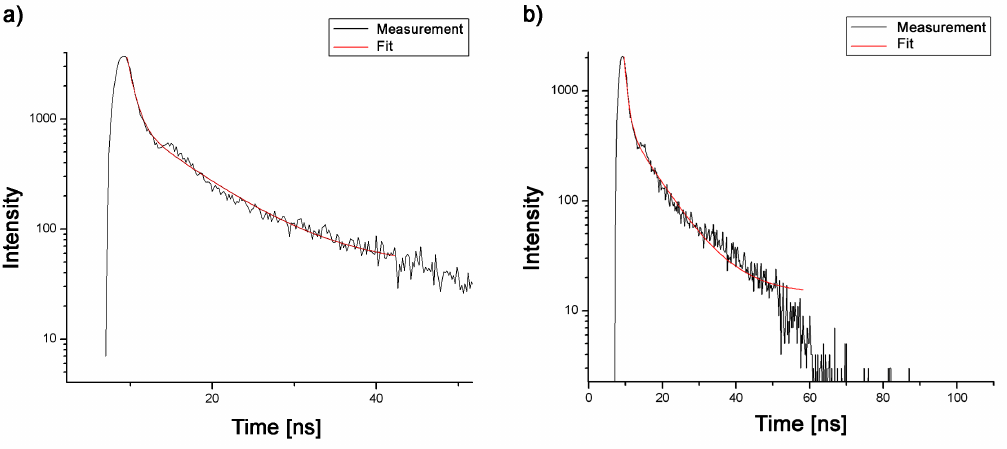
Figure 8. Fluorescence time-resolved measurements of the perovoskite within plasmonic cavity at two temperatures: ( a ) 298 K, and ( b ) 10